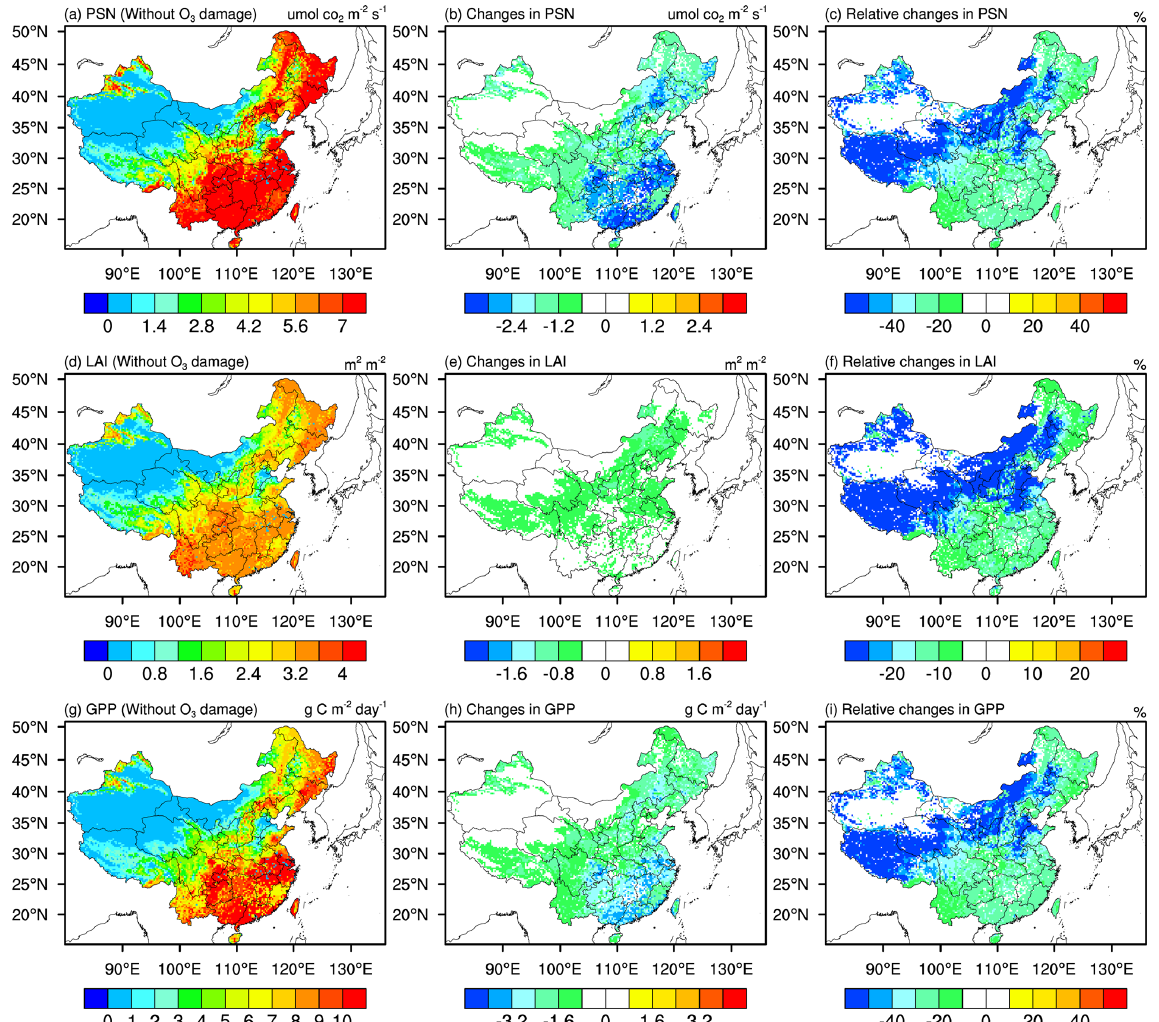
Figure 4. Spatial distribution of 2014–2017 JJA mean (a) photosynthesis rate (PSN), (d) leaf area index (LAI), and (g) gross primary productivity (GPP) from the simu_withoutO 3 experiment; absolute changes in (b) PSN, (e) LAI, and (h) GPP caused by O 3 damage; and relative changes in (c) PSN, (f) LAI, and (i) GPP caused by O 3 damage. Absolute changes are the results from simu_withO 3 minus results from simu_withoutO 3 . Relative changes are calculated from the absolute changes over the results from simu_withoutO 3 .